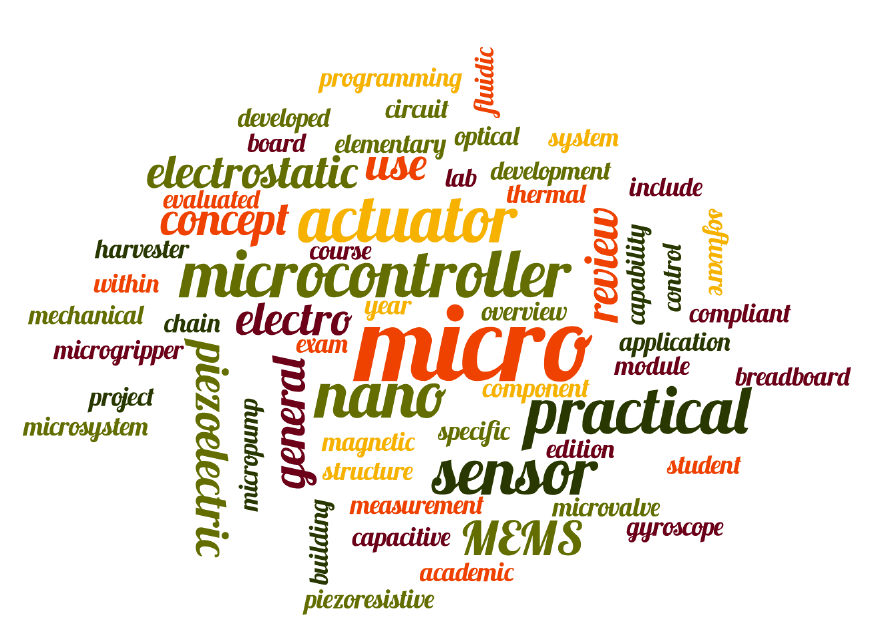
Figure 4. Most frequently mentioned words in the course